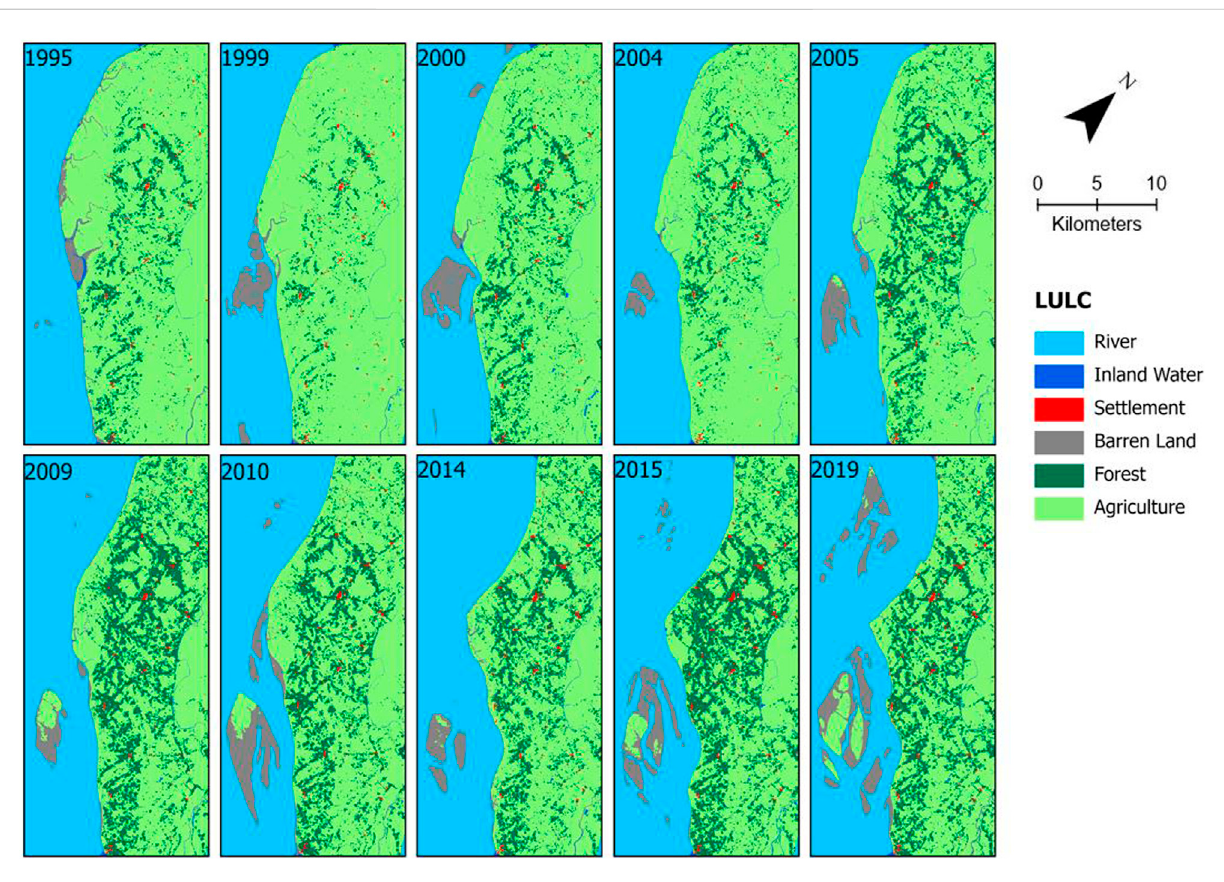
FIGURE 2 Land use and land cover (LULC) of the coastal Lakshmipur